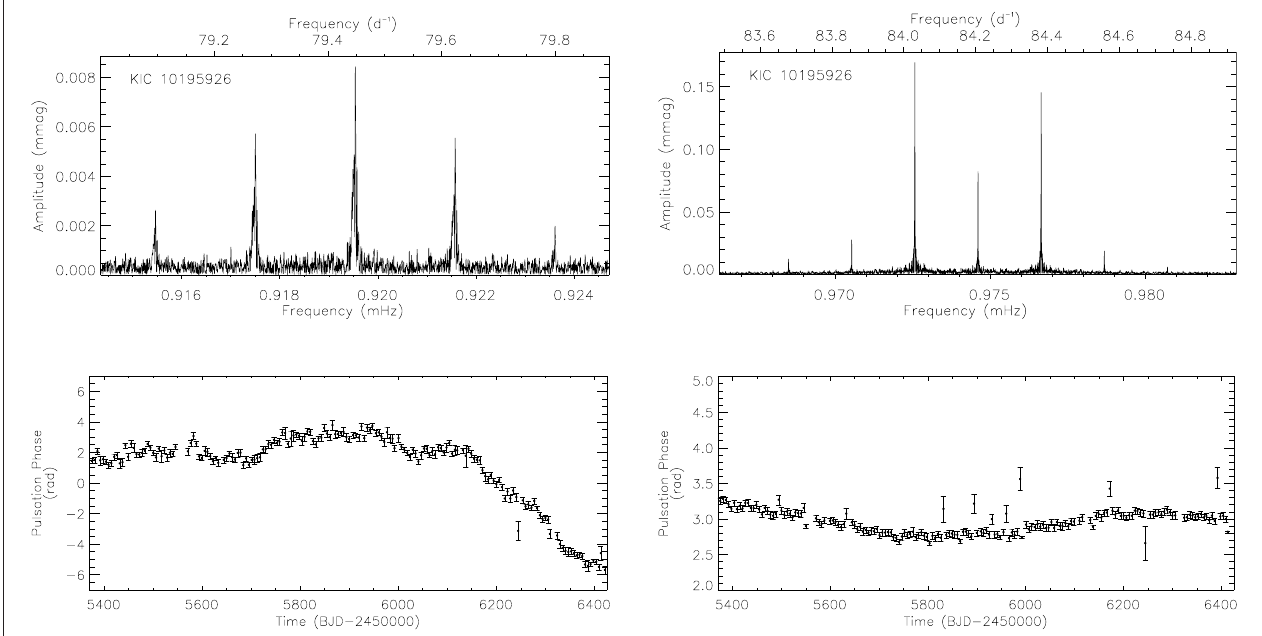
FIGURE 6 | (Top) Amplitude spectra of the two pulsation modes in KIC10195926. The left plot shows that the lowest frequency mode is split into a quintuplet with the extra data from later Kepler quarters. In both cases, the sidelobes are split by the rotation frequency (2.036 µ Hz, P = 5.685d). (Bottom) Corresponding phase variations of the pulsation modes in the top row. The high-frequency mode on the right has a fairly stable frequency over 4 years, but the low-frequency mode has a significant phase change.